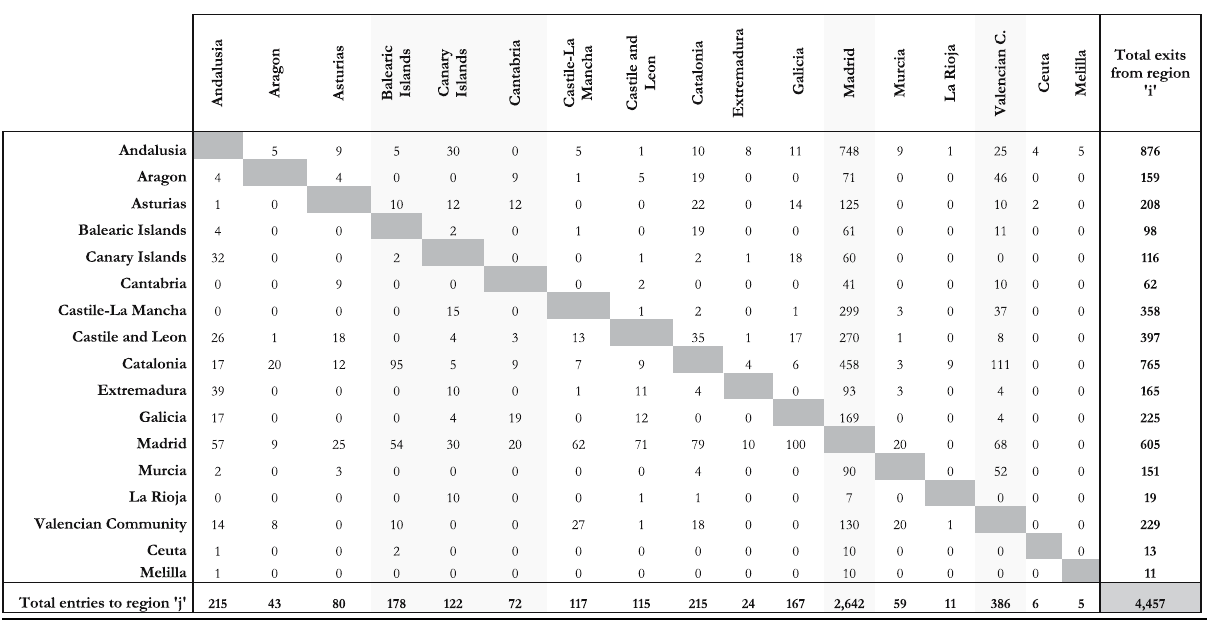
*Shaded in grey, the regions with more high - income taxpayers entering in 2012 than leaving ( after residing there in 2006 ) . Source: By the authors, based on the IRPF